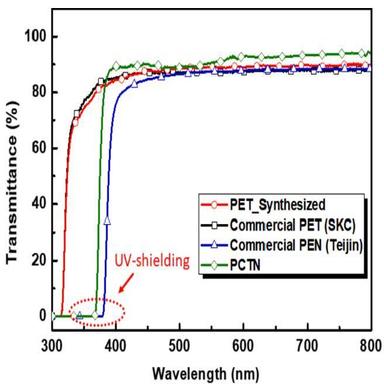
Transmittance (%) of PCTN copolyester film in comparison with commercial PET and PEN homopolyester films.